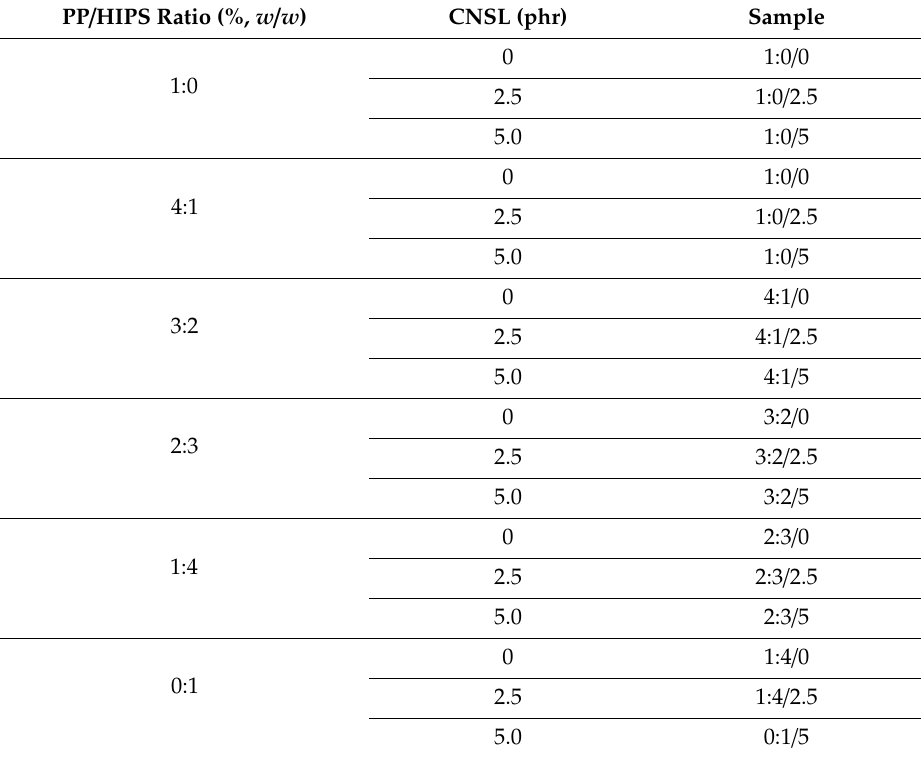
Table 3. PP / HIPS compositions in the presence of di ff erent amounts of CNSL (0; 2.5; 5 phr). PP / HIPS Ratio (%, w / w )